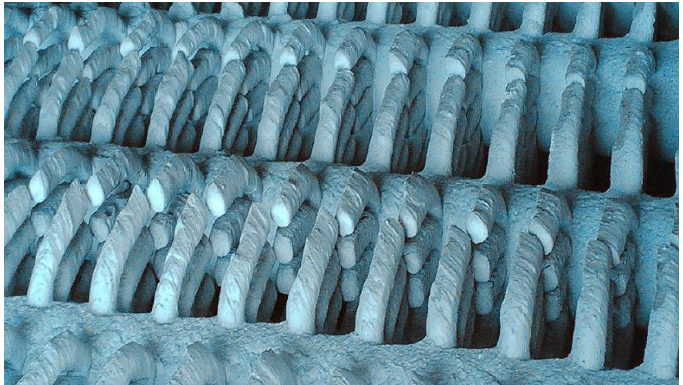
Figure 4. Fouling on the